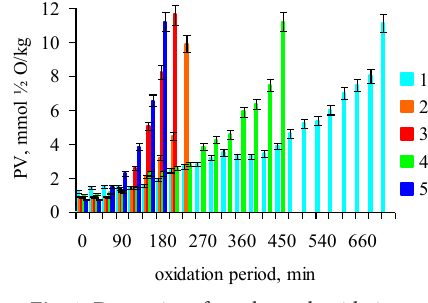
Fig. 1. Dynamics of accelerated oxidation: